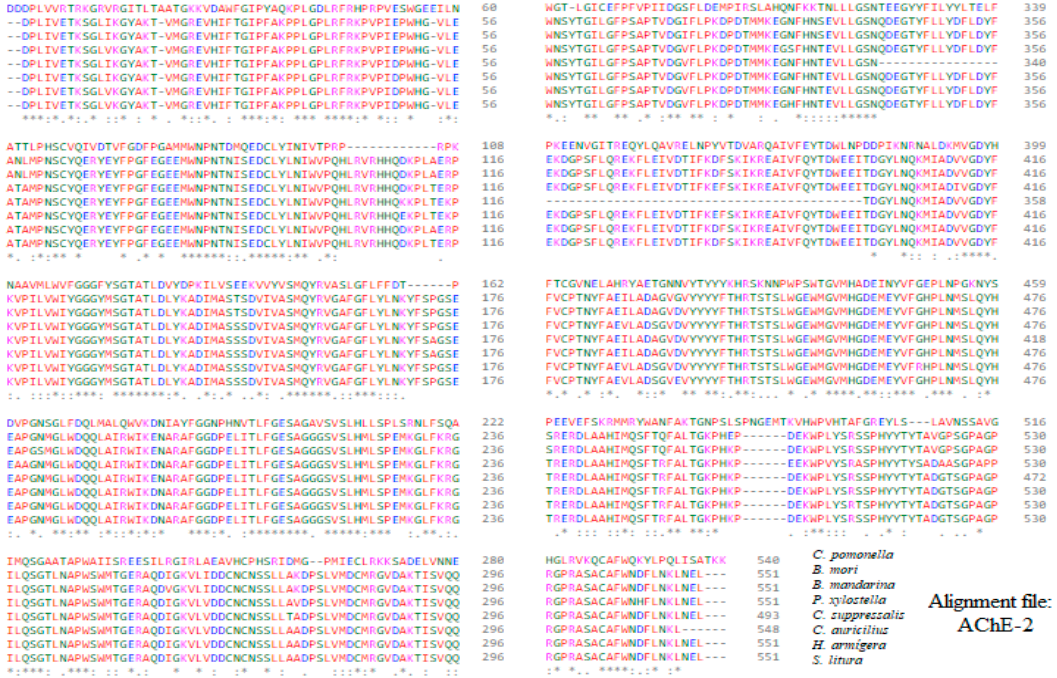
Figure A2. Alignment of the sequences of the constructed molecular models of AChE-2 (form 2 acetylcholinesterase).